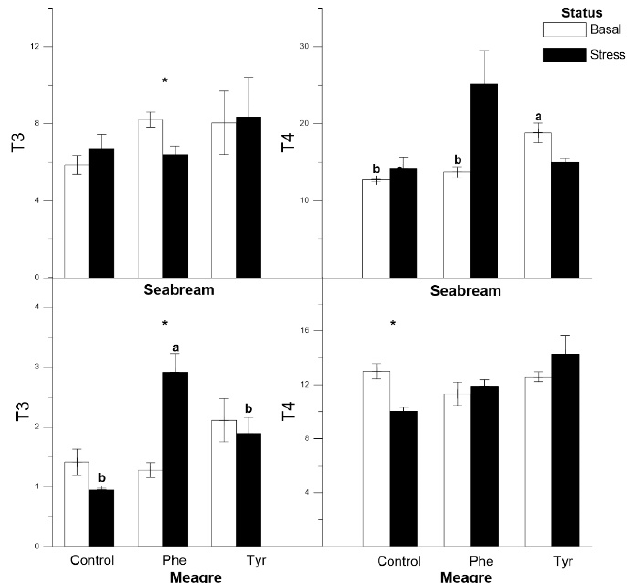
Figure 3. Plasma T3 and T4 concentrations (ng mL − 1 ) for each treatment (mean ± SE, n = 10). The white and black bars are the basal and stress values, respectively. Asterisks indicate significant differences between the basal and stress conditions. Different letters indicate significant differences among feeding treatments within every condition.